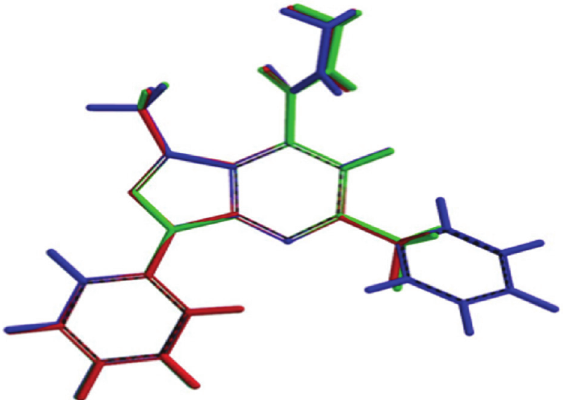
Figure 2 - The most stable conformations superposition. 4a (red), 4b (blue) and 4c